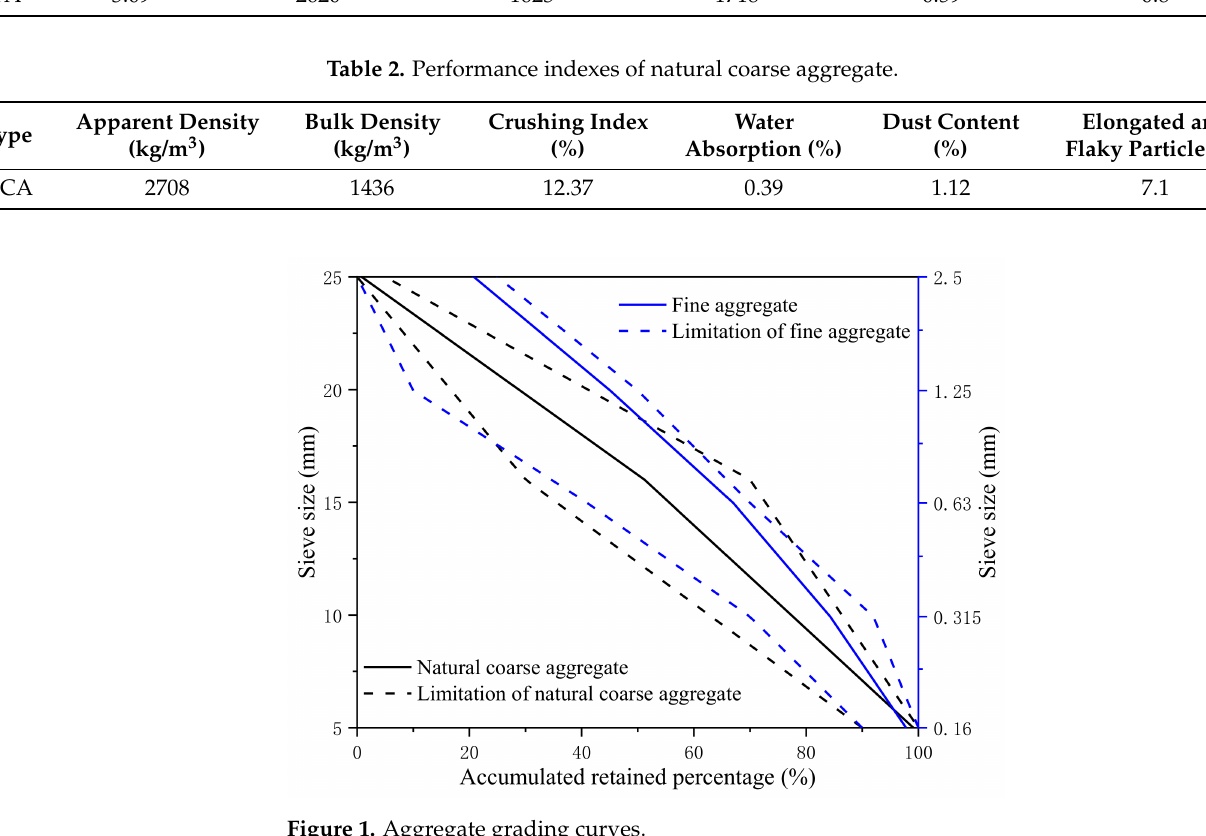
Figure 1. Aggregate grading curves. Table 3. Mix ratio of